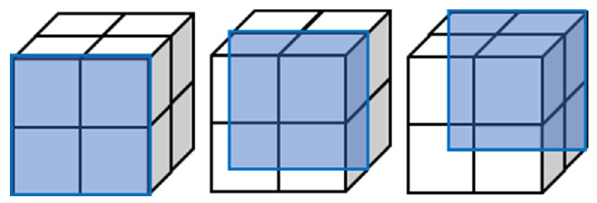
Fig. 10 Illustration of the slicing the system with the X–Z